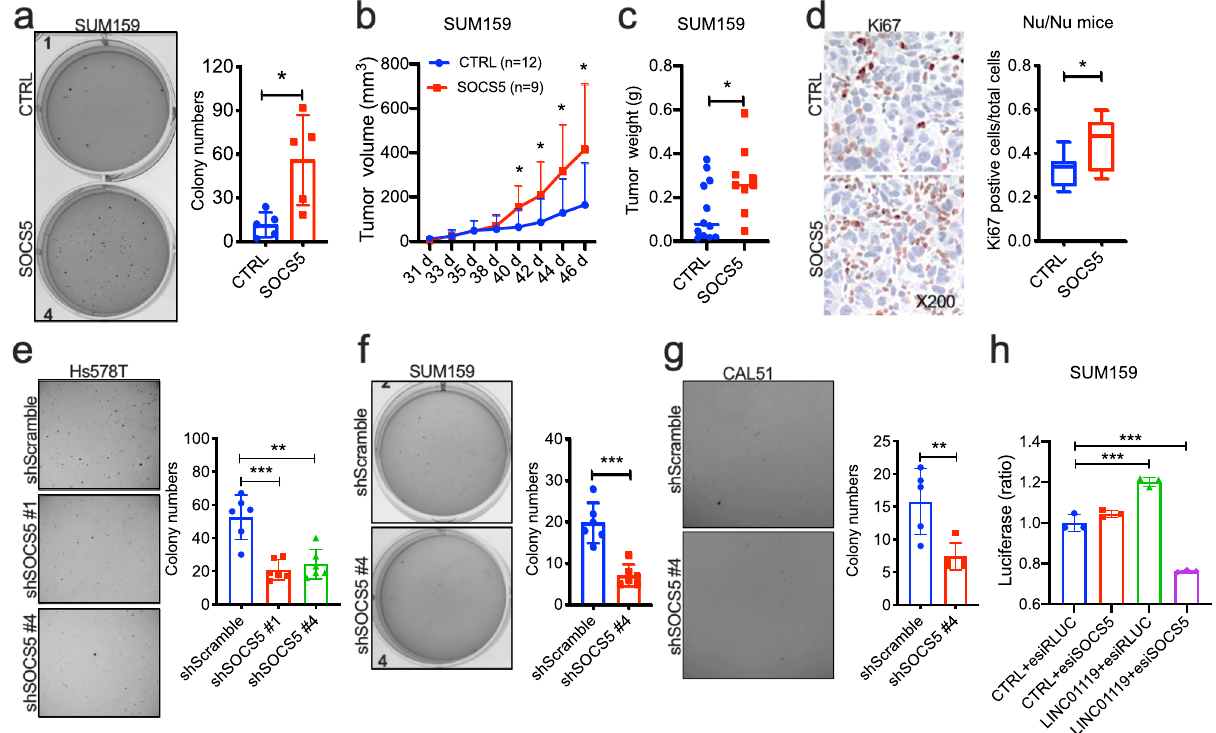
Fig. 6 Critical role for SOCS5 in TNBC cell growth. a Left: representative images of anchorage-independent growth patterns of controls versus SUM159 cells stably expressing human SOCS5. Right: ImageJ quantitation of colony numbers in Left displayed as mean ± SD of n = 5. b Growth kinetics of indicated orthotopic tumors derived from SUM159 controls ( n = 12) or SUM159 cells expressing pLVX-SOCS5 ( n = 9) in Nu/Nu nude mice measured by digital calipers with mean ± SD indicated per time point. c Weight of the indicated SUM159 tumors in B with the median shown. d Left: representative images of immunohistochemistry of Ki67 in tumor tissues in c ; Right: quantitation of Ki67 positive cells in Left displayed as box-and-whisker plots representing the median (centerline) and inter-quartile range (IQR; box). The whiskers extend up to 1.5 times the IQR from the box to the smallest and largest points. e Left: representative images of anchorage-independent growth patterns of Hs578T cells stably expressing sh scramble control, shSOCS5#1 and shSOCS5#4. Right: ImageJ quantitation of colony numbers in Left displayed as mean ± SD of n > 3. f Left: representative images of anchorage-independent growth patterns of controls versus SUM159 cells stably expressing SOCS5 shRNA#4. Right: ImageJ quantitation of colony numbers in Left displayed as mean ± SD of n > 3. g Left: representative images of anchorage-independent growth patterns of controls versus SOCS5 shRNA#4 in CAL51 cells. Right: ImageJ quantitation of colony numbers in Left displayed as mean ± SD of n > 3. h Proliferation (mean ± SD of n = 3) of control or LINC01119-over-expressing SUM159 cells transfected with esiRLUC or esiSOCS5 measured using CellTiter after 72